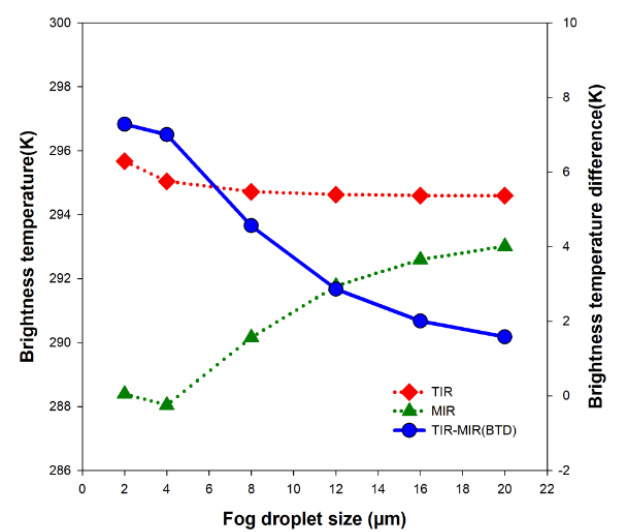
Figure 4. BT (K) and BTD (K) variation with